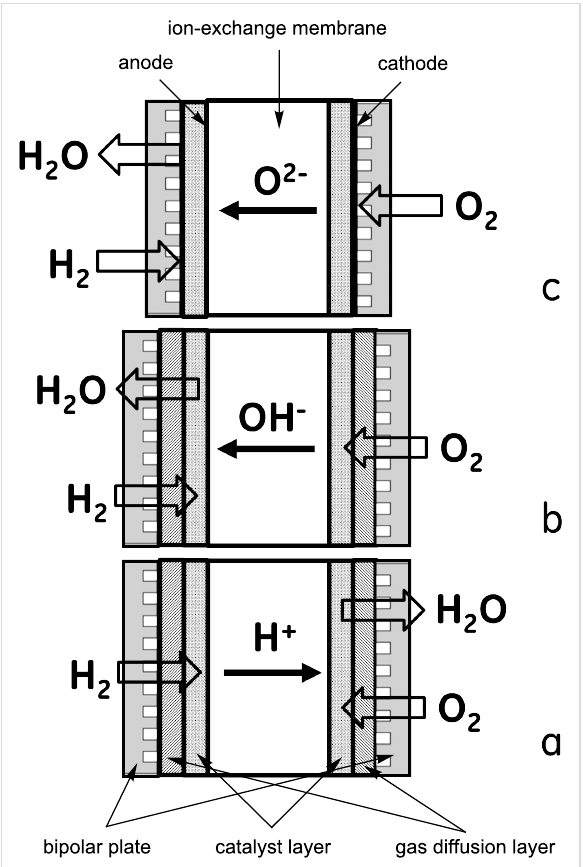
Figure 1: The electrochemistry and major components of liquid fuel cells with proton (a), alkaline (b) and solid oxide (c) ion-exchange